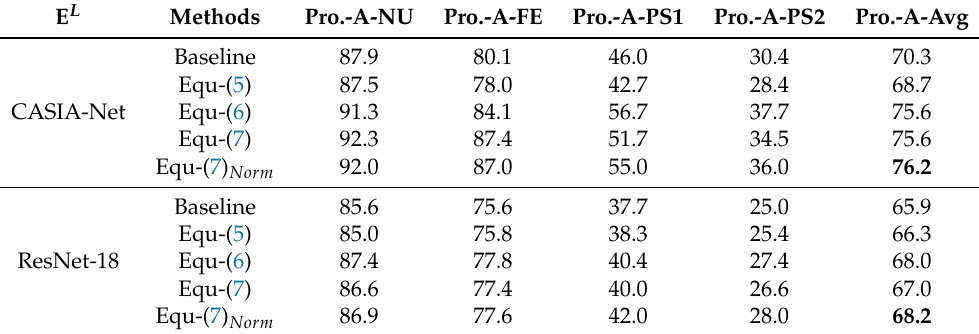
Table 8. Rank-1 identification rates (%) of feature-based network in face recognition on low-quality data sets under variations. The results in ’Pro.-A-Avg’ are the average rates of specific methods, and the best accuracy is made bold.